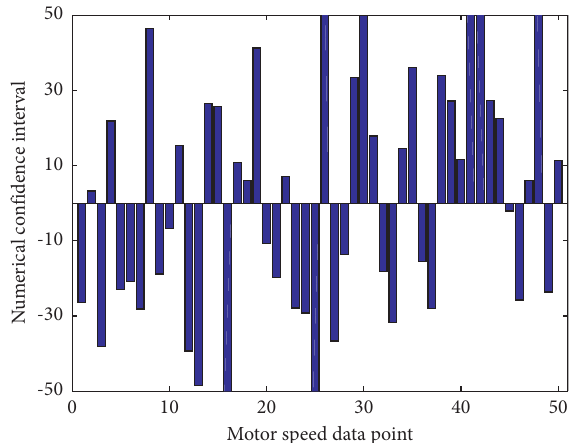
Figure 9: Histogram of the fluctuation interval of the fan operating state.